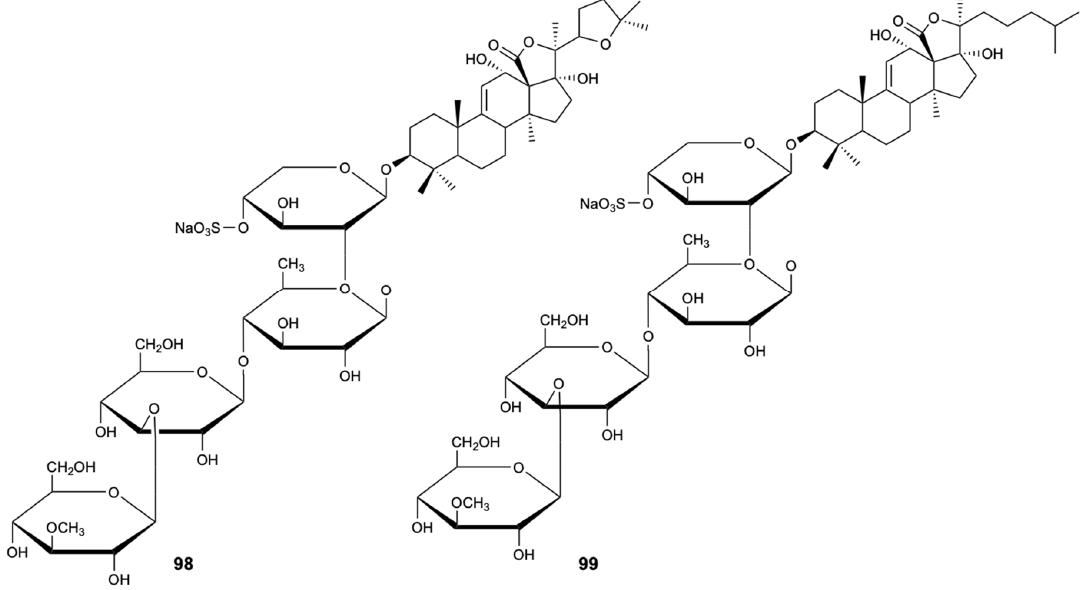
Figure 24. Structures of compounds 98 and 99 .